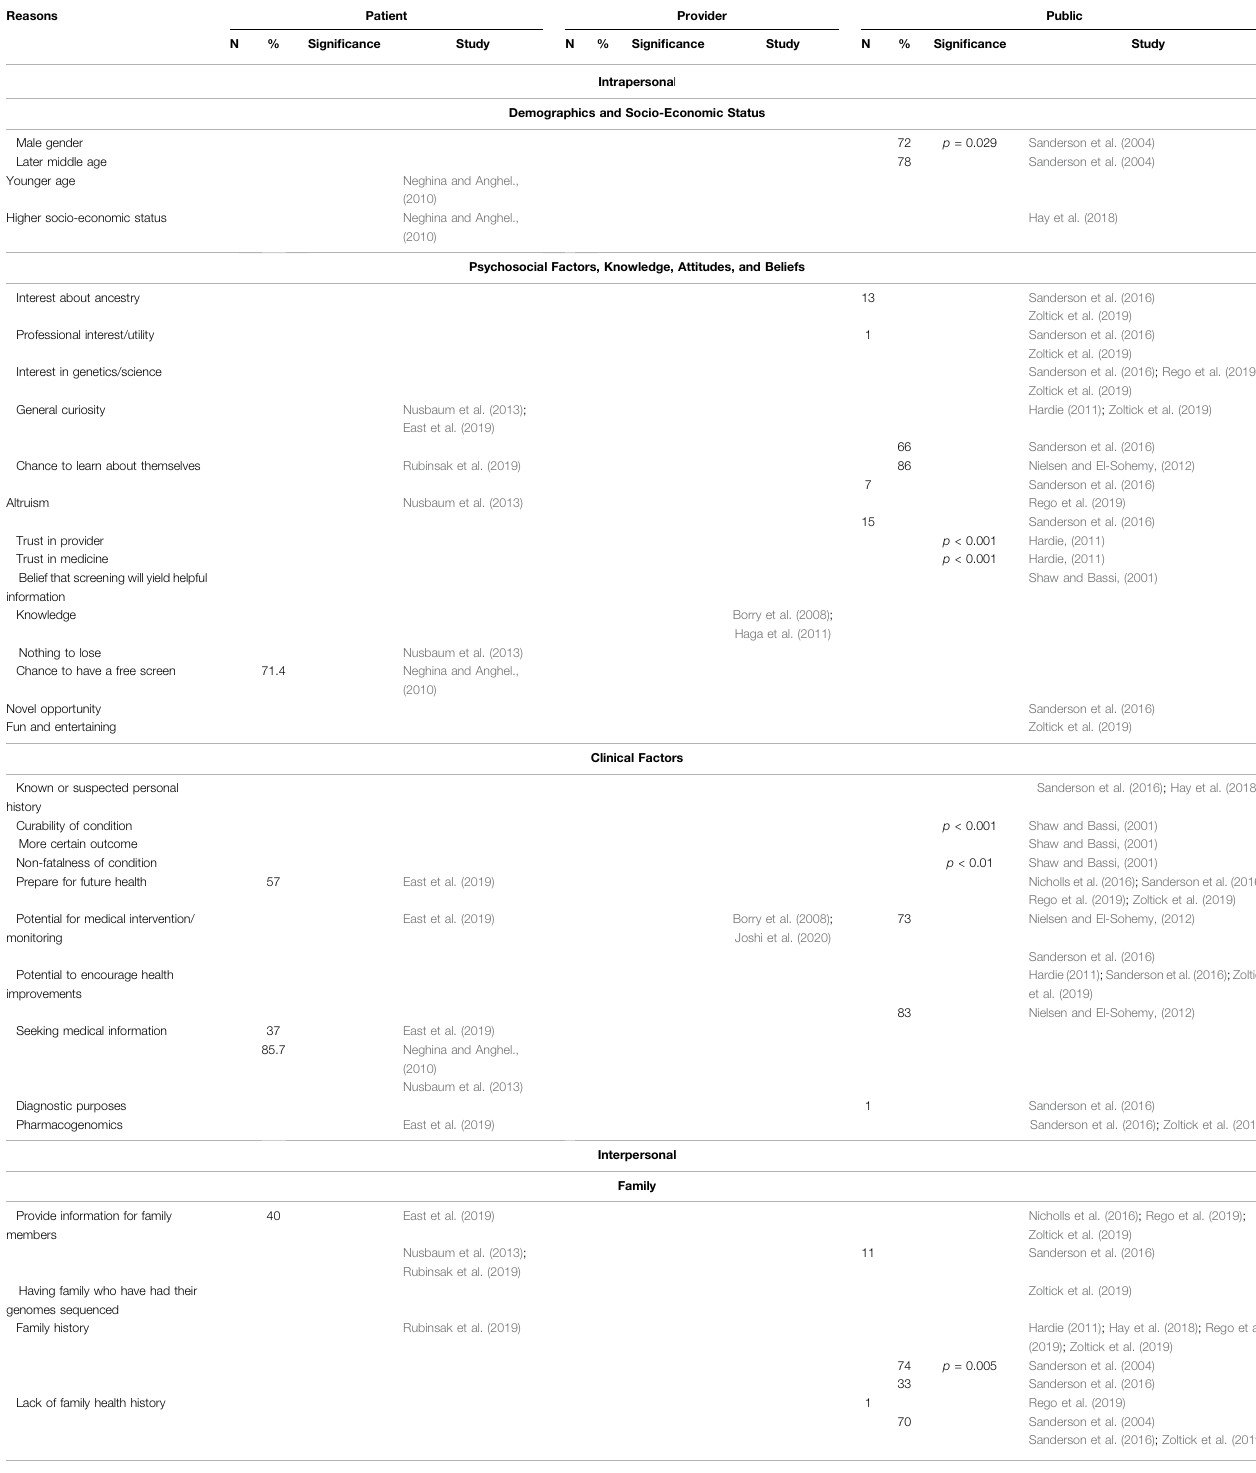
TABLE 3 | Facilitators to interest and participation in population genetic